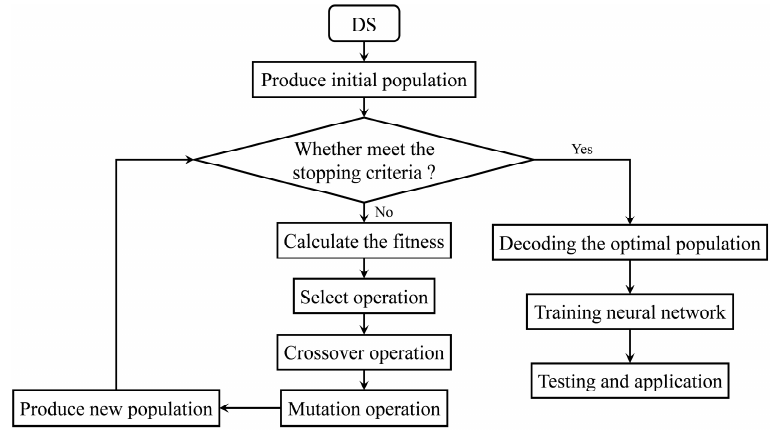
Figure 5. Calculation flow of GA-BP algorithm.